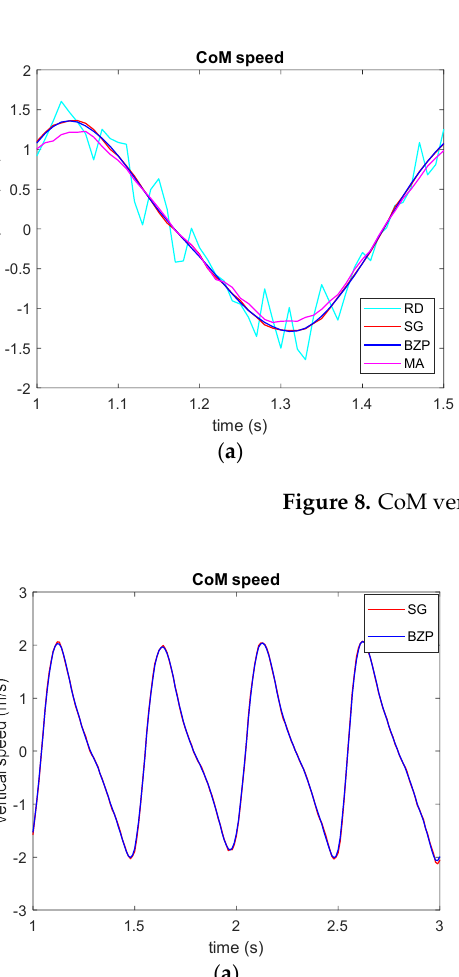
Figure 9. CoM vertical speed ( a ) and acceleration ( b ) in forced hopping.